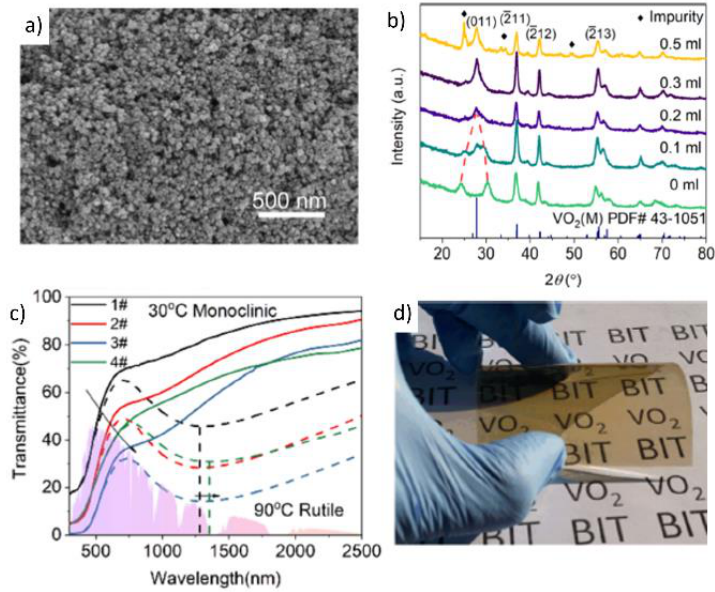
Figure 10. ( a ) SEM image of the VO 2 NPs with 0.2 mL of H 2 O 2 , ( b ) XRD patterns of as-synthesis VO 2 NPs with different amounts of H 2 O 2 , ( c ) temperature-dependent transmittance spectra of samples at 30 ◦ C (bold line) and 90 ◦ C (dashed line), and ( d ) the VO 2 (M) NPs-based flexible films. Reproduced with permission from [77]. Copyright 2018, American Chemical